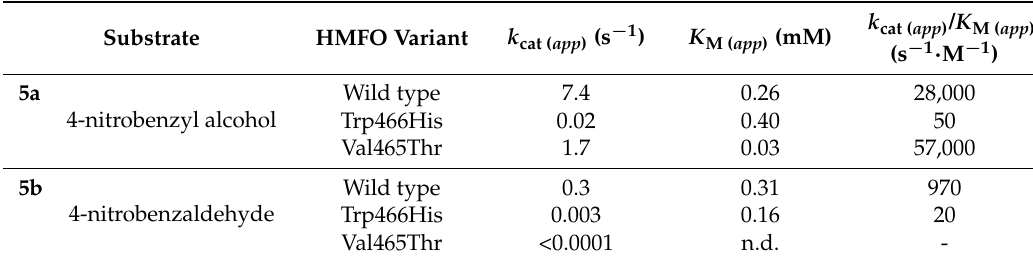
Table 2. Steady state kinetics of wild-type HMFO and selected variants in the oxidation of p -nitrobenzyl alcohol ( 5a ) and p -nitrobenzaldehyde ( 5b